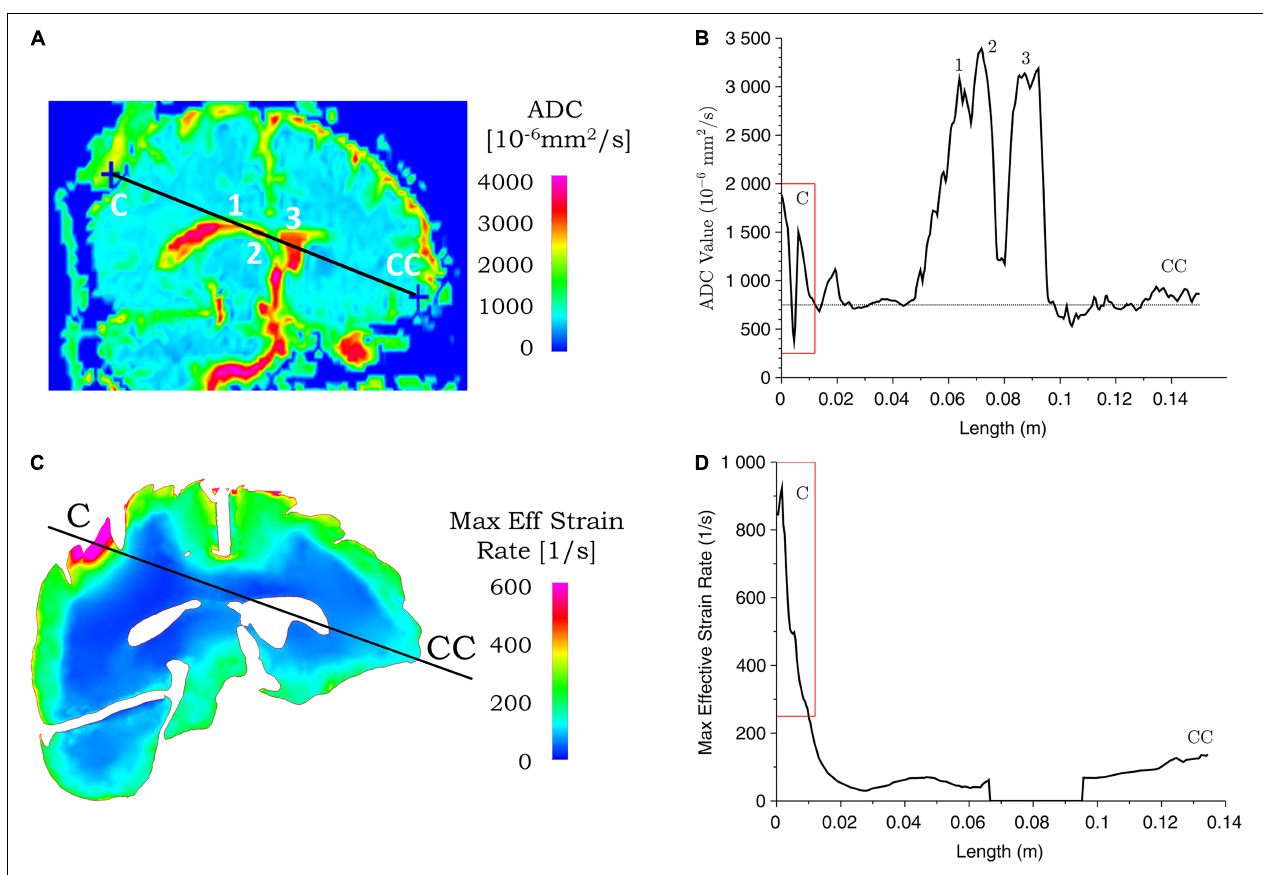
FIGURE 8 | Correspondence between ADC values from clinical data and simulated maximum effective strain rate for case 1. ADC (A) and maximum effective strain rate (C) contours are shown for the coup–contrecoup plane; ADC (B) and maximum effective strain rate (D) plot along the coup–contrecoup (C-CC) line with the points 1, 2, and 3 (inside ventricles) marked in (A) . The dotted line represents approximate mean value of ADC in (B) . Maximum effective strain rate shown in cerebrum, cerebellum, and brainstem only. TABLE 4 | Comparison between the change in ADC and biomechanical measures for the two cases. Case